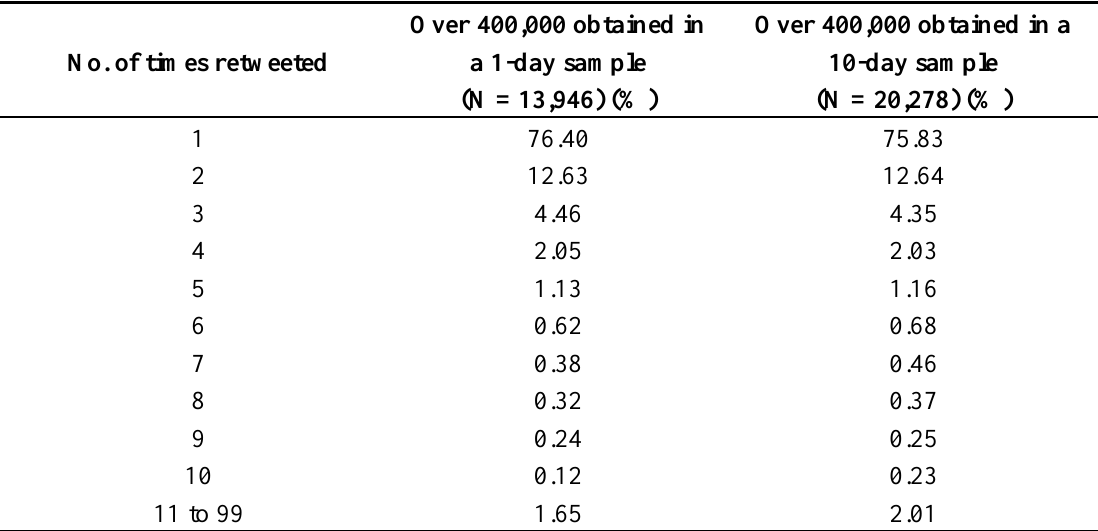
Table 2. Number of retweets.